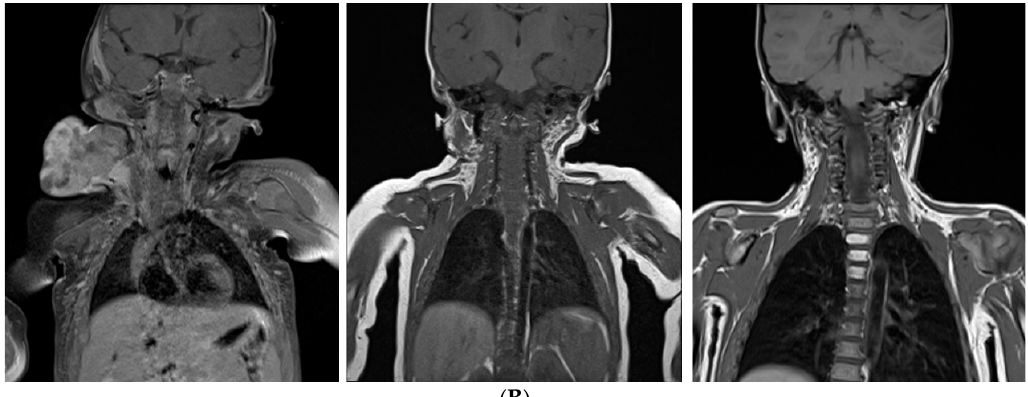
Figure 3. Response to standardized chemotherapy of infants with extensive primary eMRT, imaging results. ( A ) Diagnostic imaging at 3 months of age with inoperable, liver eMRT (8.2 × 8.4 × 7.4 cm), without distant metastasis, without germline mutation. Before GTR (gross total resection), one course ICE (ifosfamide, carboplatin, etoposide) according to EU-RHAB was given. The patient achieved CR (complete remission) and the chemotherapy was continued according to EU-RHAB with four courses of DOX (doxorubicin), three courses of VCA (vincristine, cyclophosphamide, ac- tinomycin) and four courses of ICE. The patient survived 60 months after diagnosis in continuing CR (complete remission). ( B ) Diagnostic imaging at 3 months of age with inoperable, neck eMRT (4.9 × 5 × 6.4 cm), without distant metastasis, without germline mutation. The tumor was resected subtotally (2.5 × 1.2 × 1 cm), and 50% to 25% decrease in tumor volume (IMP–improvement) was detected. After subtotal resection, therapy was continued according to EU-RHAB with two courses of DOX, two courses of ICE, and one course of VCA, and GTR (gross total resection) was performed. After GTR the patient received one course of VCA, high dose chemotherapy (HDCT) and mainte- nance therapy according to EU-RHAB. The patient achieved CR (complete remission), and one year later RTx was given to tumor bed up to 19.8 Gy with boost up to 16.2 Gy. The patient survived 111 months after diagnosis in continuing CR (complete remission).